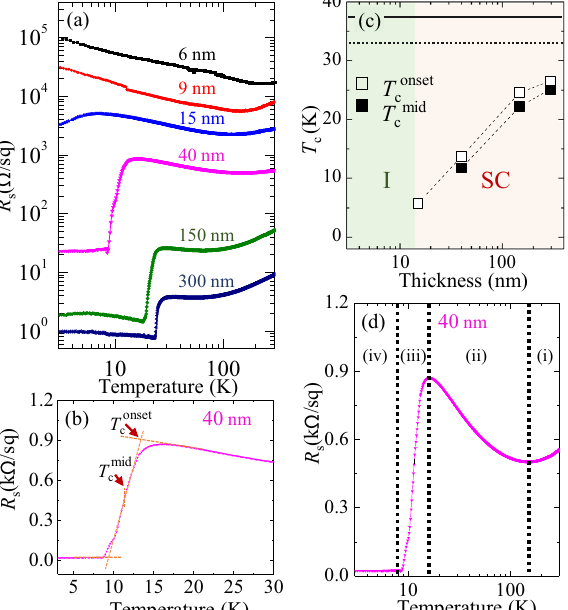
Figure 1. ( a ) Temperature dependence of sheet resistance R s for La 1.85 Sr 0.15 CuO 4 thin films with film thicknesses of 6, 9, 15, 40, ~150 and ~300 nm. ( b ) The magnified linear-scale R s − T curve of the 40-nm- thick film. The onset superconducting transition temperature is defined by the crossing point of two yellow extrapolated lines. The midpoint temperature is defined as the temperature at which resistance becomes half of the resistance at the onset temperature relative to the base resistance. ( c ) Superconducting transition temperatures versus logarithmic film thickness. The horizontal solid (dashed) line indicates the onset (midpoint) transition of the bulk target. ( d ) Semi-logarithmic R s − T plot for the 40-nm-thick film. The labels of (i) to (iv) represent four conduction regimes that correspond to the metal, insulator, transition, and